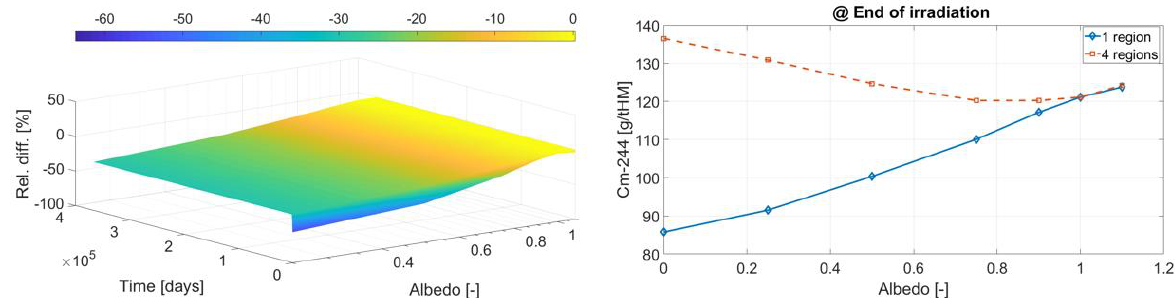
Figure 10. Differences in 244 Cm concentration between 1 region and 4 region cases as a function of albedo and irradiation + subsequent cooling